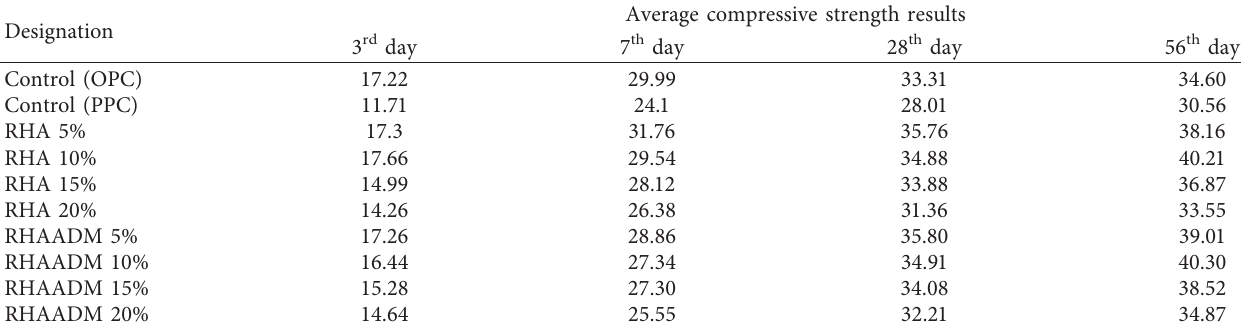
Table 5: Average compressive strength results of concrete cubes.